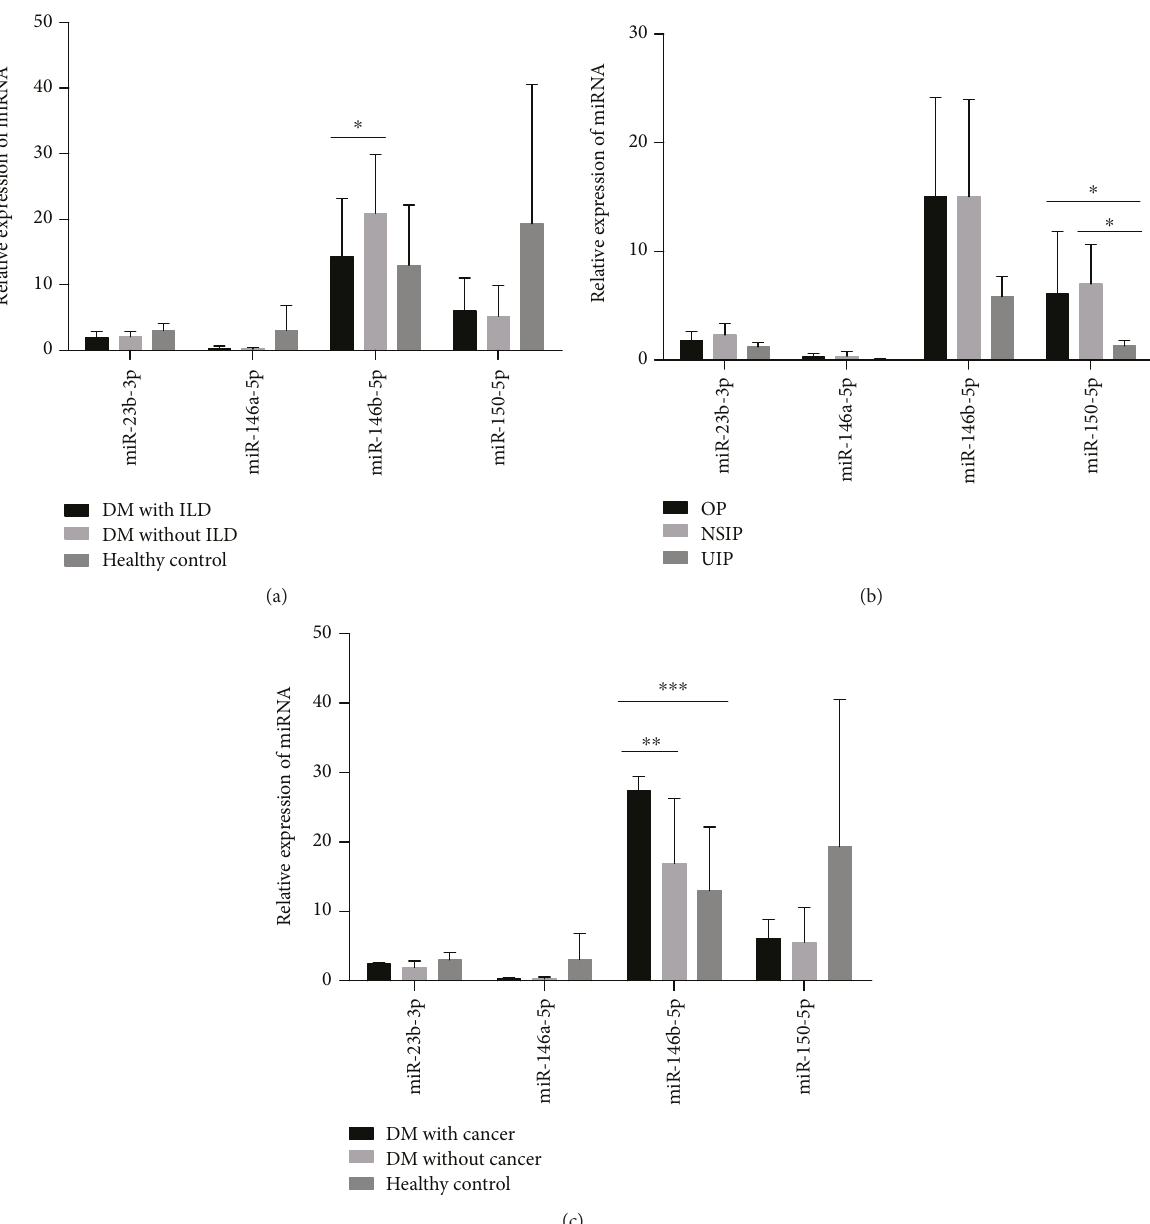
Figure 4: Correlations between serum miRNA levels and organ involvement in DM patients. (a) Signi fi cant di ff erence was observed between expression levels of serum miR-146b-5p in DM patients with and without ILD ( P = 0 013 ). (b) The serum levels of miR-150-5p were signi fi cantly higher in DM patients with NSIP than in those with UIP ( P = 0 044 and P = 0 029 , respectively). (c) The expression levels of serum miR-146b-5p were higher in DM patients with cancer than in those without cancer and HCs ( P = 0 001 and P < 0 001 , respectively). Multiple comparisons for continuous variables were performed using the analysis of variance (ANOVA). ∗∗∗ P < 0 001 , ∗∗ P < 0 01 , and ∗ P < 0 05